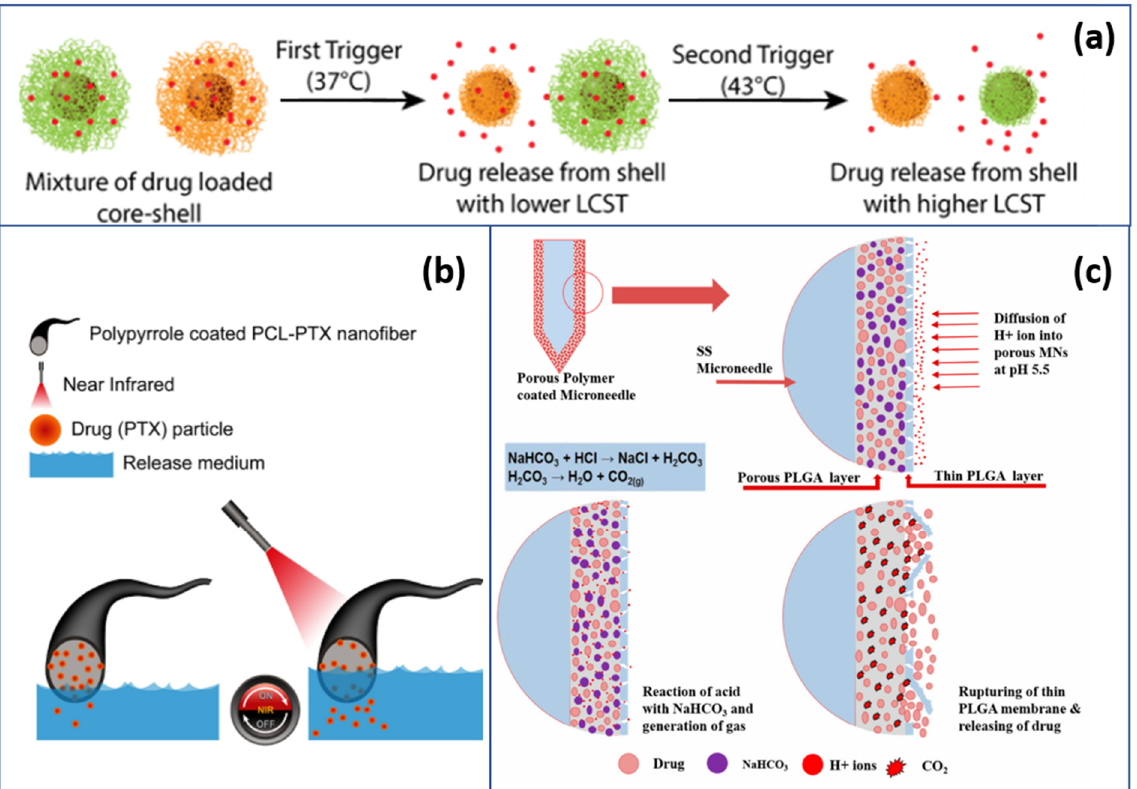
Figure 6. Applications using responsive polymers: ( a ) schematic representation of the trigger-dependent sustained release of a drug from a mixture of nanoparticles having varying trigger sensitivities [121,122]; ( b ) schematic illustration of the NIR-triggered drug release from the PPy-coated fiber (Reprinted with permission from Tiwari, A. P.; Hwang, T. I.; Oh, J.-M.; Maharjan, B.; Chun, S.; Kim, B. S.; Joshi, M. K. K.; Park, C. H.; Kim, C. S. pH/NIR-Responsive Polypyrrole-Functionalized Fibrous Localized Drug-Delivery Platform for Synergistic Cancer Therapy. ACS Appl. Mater. Interfaces , 2018 , 10 (24), 20256–20270. Copyright American Chemical Society) [118]; ( c ) schematic illustration of the pH-responsive release system [123].